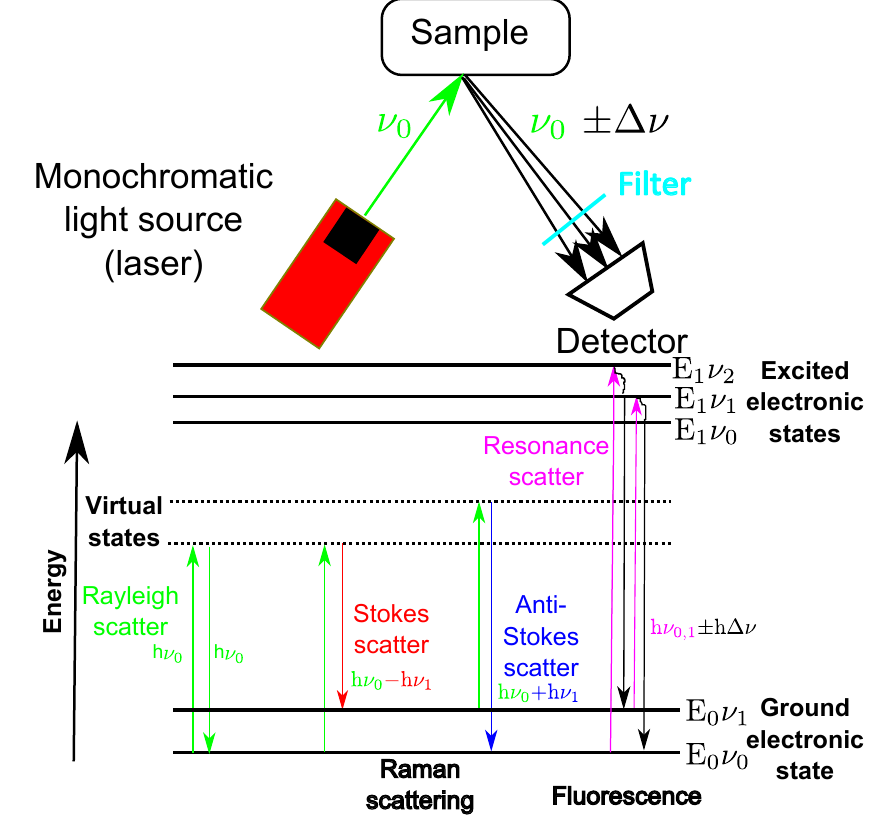
Figure 1. Schematic of the fundamental principles of Raman spectroscopy, highlighting the main scattering and fluorescence excitations of a sample after it is excited using a monochromatic light source of frequency equal to ν 0